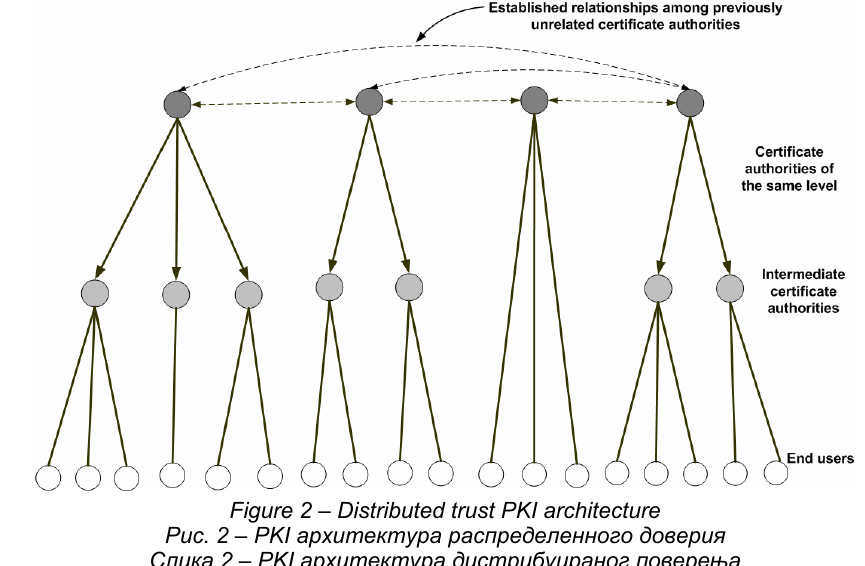
Figure 2 – Distributed trust PKI architecture Рис . 2 – PKI архитектура распределенного доверия Слика 2 – PKI архитектура дистрибуираног